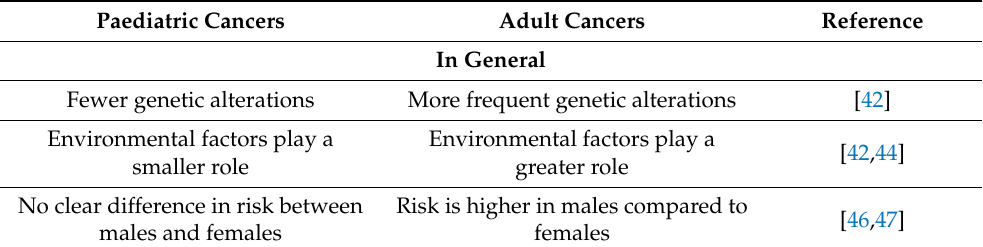
Table 2. Summary of differences between paediatric and adult HCCs